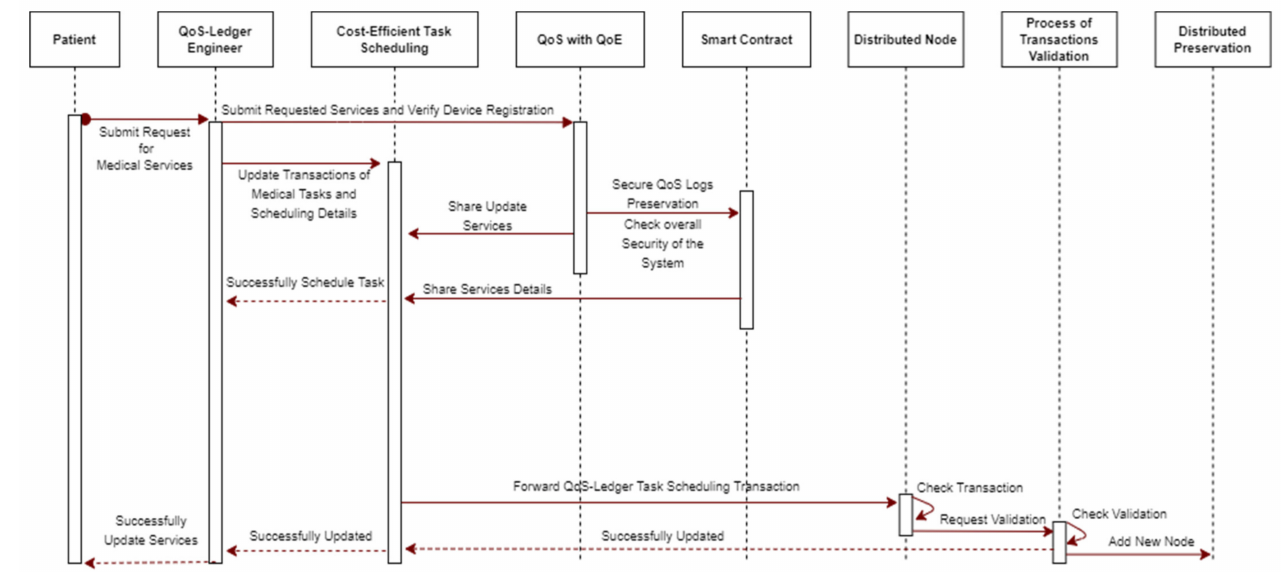
Figure 7. Operations of the proposed QoS-ledger node transaction verification and validation